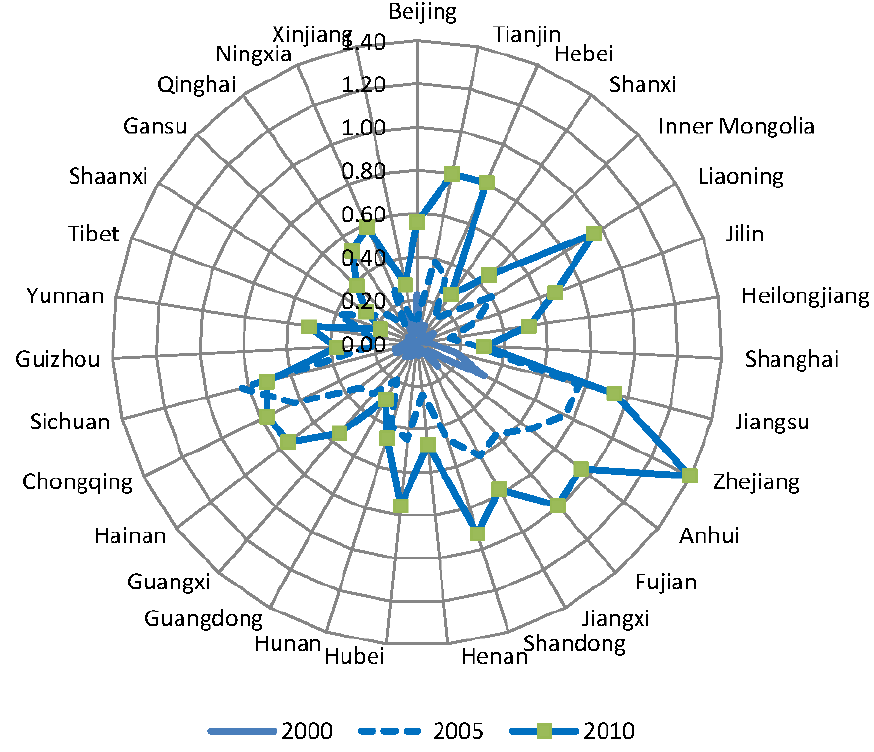
Figure 4. Radar chart of provincial land revenue from compensable use/budgetary fiscal revenue in 2000, 2005 and